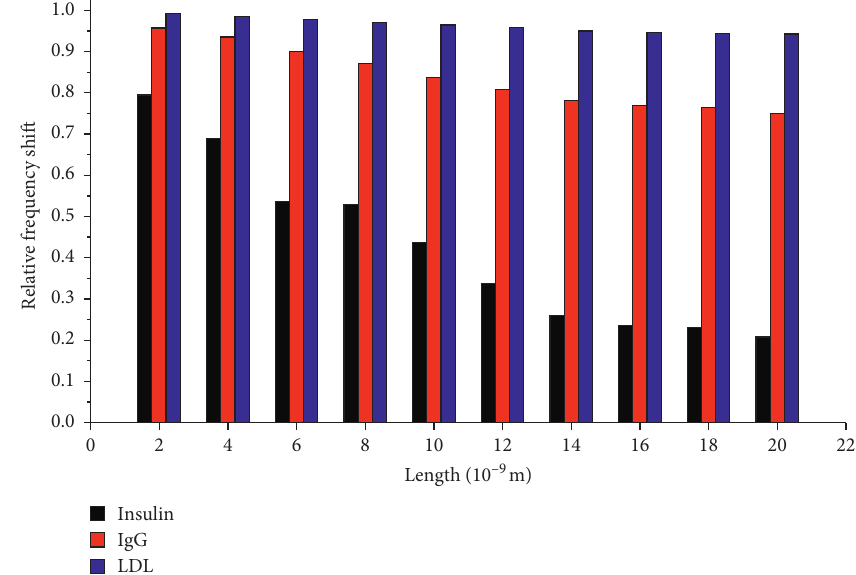
Figure 11: Comparisons of fixed-fixed boundary relative frequency shift analysis for CNT.